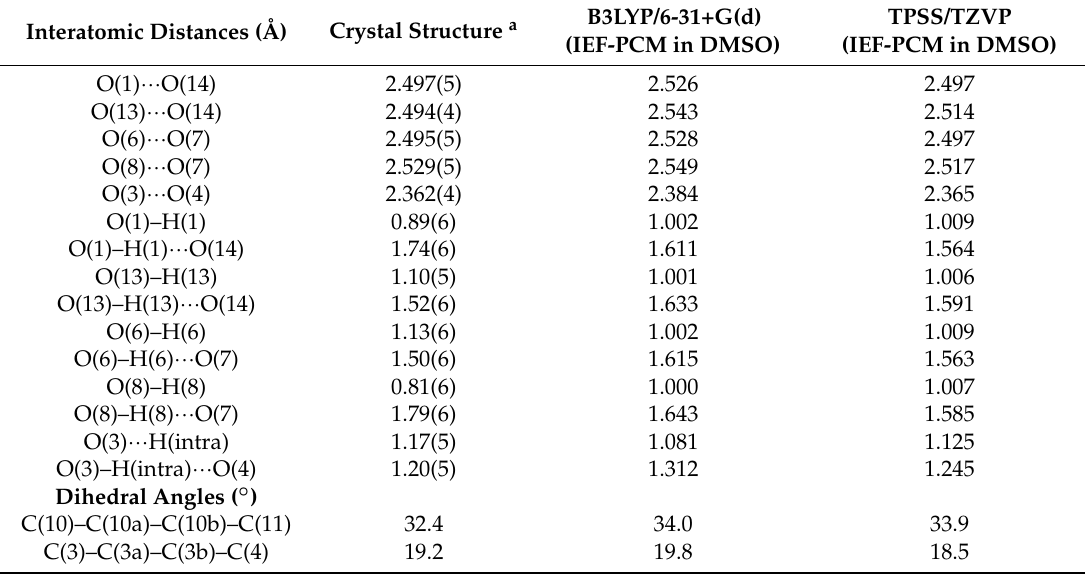
Table 3. Comparison of structural data of the calculated structures, at the B3LYP/6-31+G(d) (IEF-PCM in DMSO) and at the TPSS/TZVP (IEF-PCM in DMSO) level of theory, of the hypericinate ( 1a ) with those of the X-ray structure [97]. Reprinted, with permission, from [50]. Copyright 2016, by Elsevier Science Ltd. Interatomic Distances